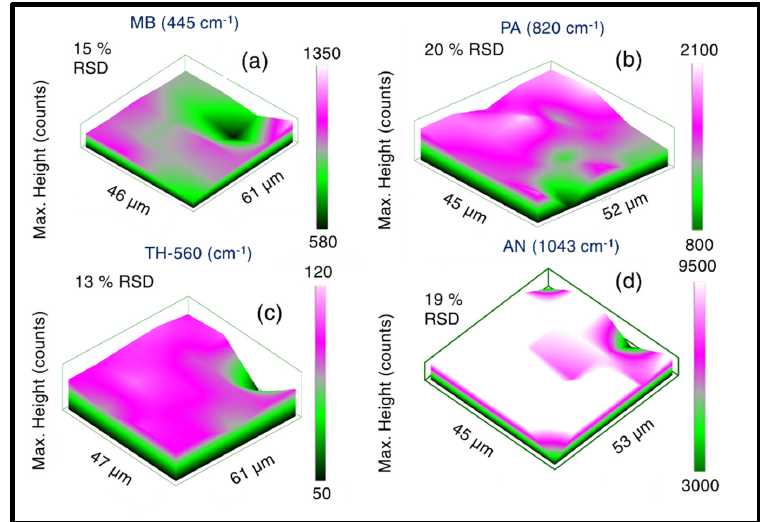
Figure 8. SERS mapping data of AgNS2 obtained with a micro-Raman spectrometer engaging 25% (of full power) of 532 nm laser, a 50× objective, with the following experimental parameters: acquisition time 5 s, accumulation number 3 and a mapping step size of 10 μ m. A 3D representation of the Raman-mapped area of ~(45 μ m × 50 μ m), probing various molecules as ( a ) MB, ( b ) PA, ( c ) TH, ( d ) AN is presented.